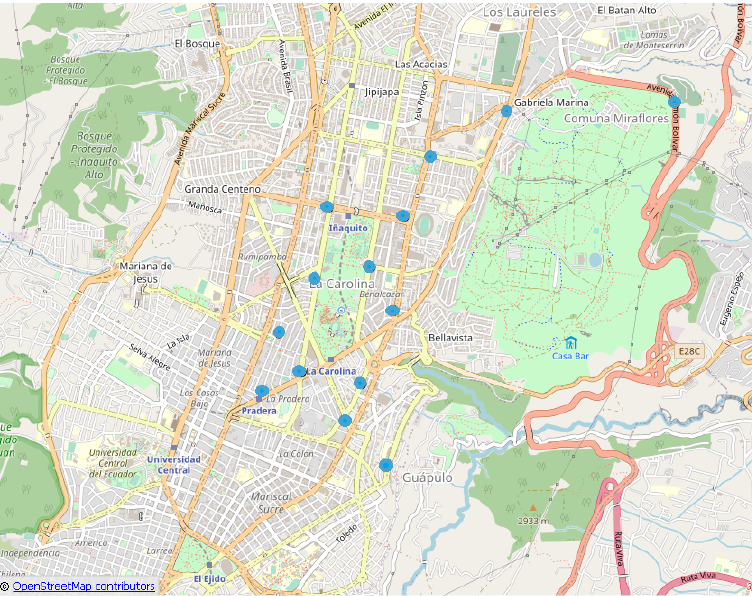
Figure 11. Hotspot of each cluster Cl k (blue